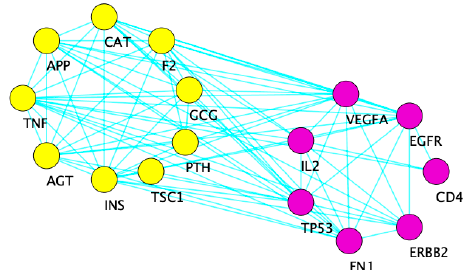
Figure 4. Cytoscape diagram showing the interaction network of 16 common genes between the